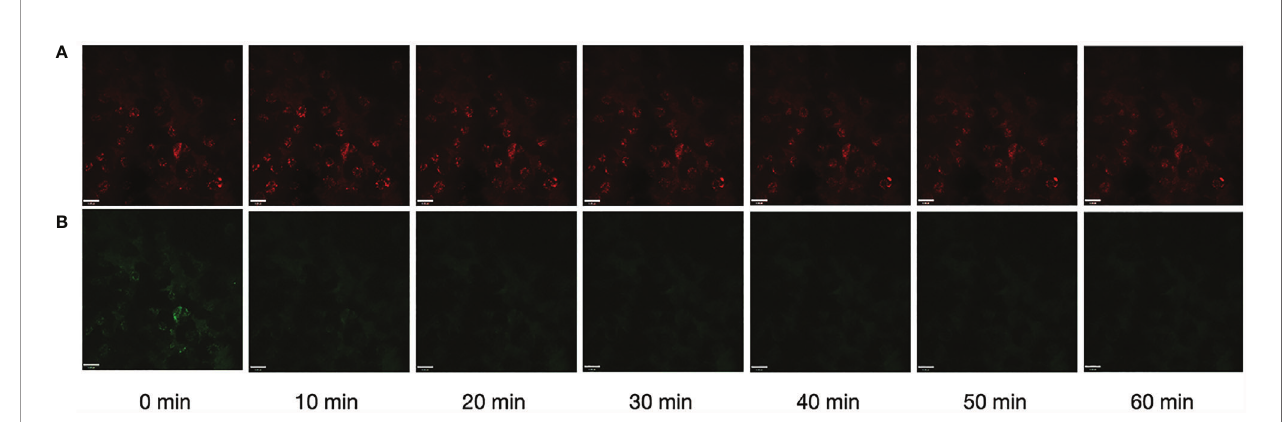
FIGURE 6 | Photostability of fl uorescence imaging of Neuro-2a cells with Rh-Mg-PVP@SiO 2 -TPP NPs (A) and MitoTracker Green (B) . Scale bar represents 11 m